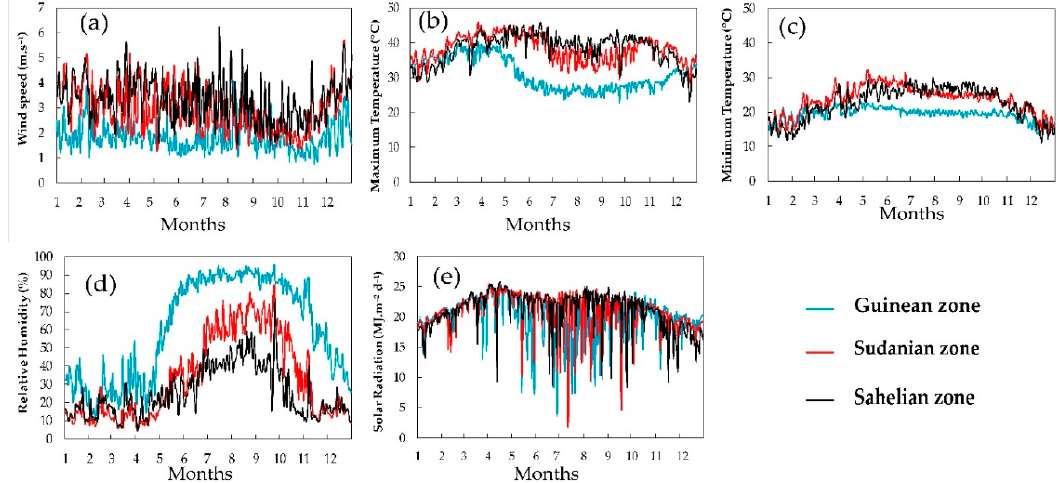
Figure 2. Daily average of climatic variables in the Senegal river basin according to climatic zones over 1984–2017: ( a ) Wind speed; ( b ) Maximum Temperature; ( c ) Minimum Temperature; ( d ) Relative Humidity; ( e ) Solar Radiation. (average calculated from 26 stations for the Sahelian zone, 36 stations for the Sudanian zone and 2 stations for the Guinean zone.).